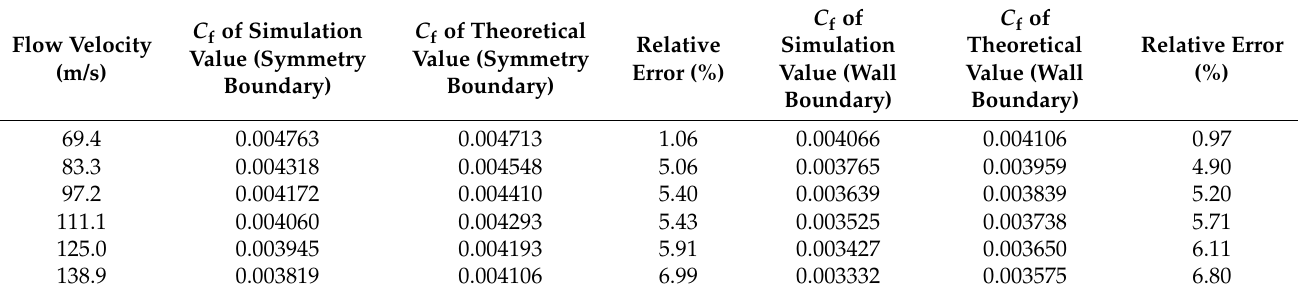
Table 1. Comparison between calculated values and theoretical values.